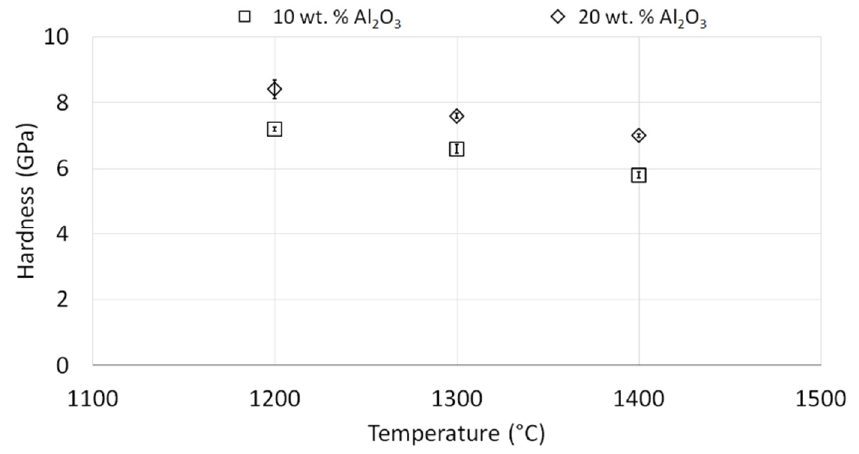
Figure 15. Hardness values for NiAl-10%Al 2 O 3 samples and NiAl-20%Al 2 O 3 samples.